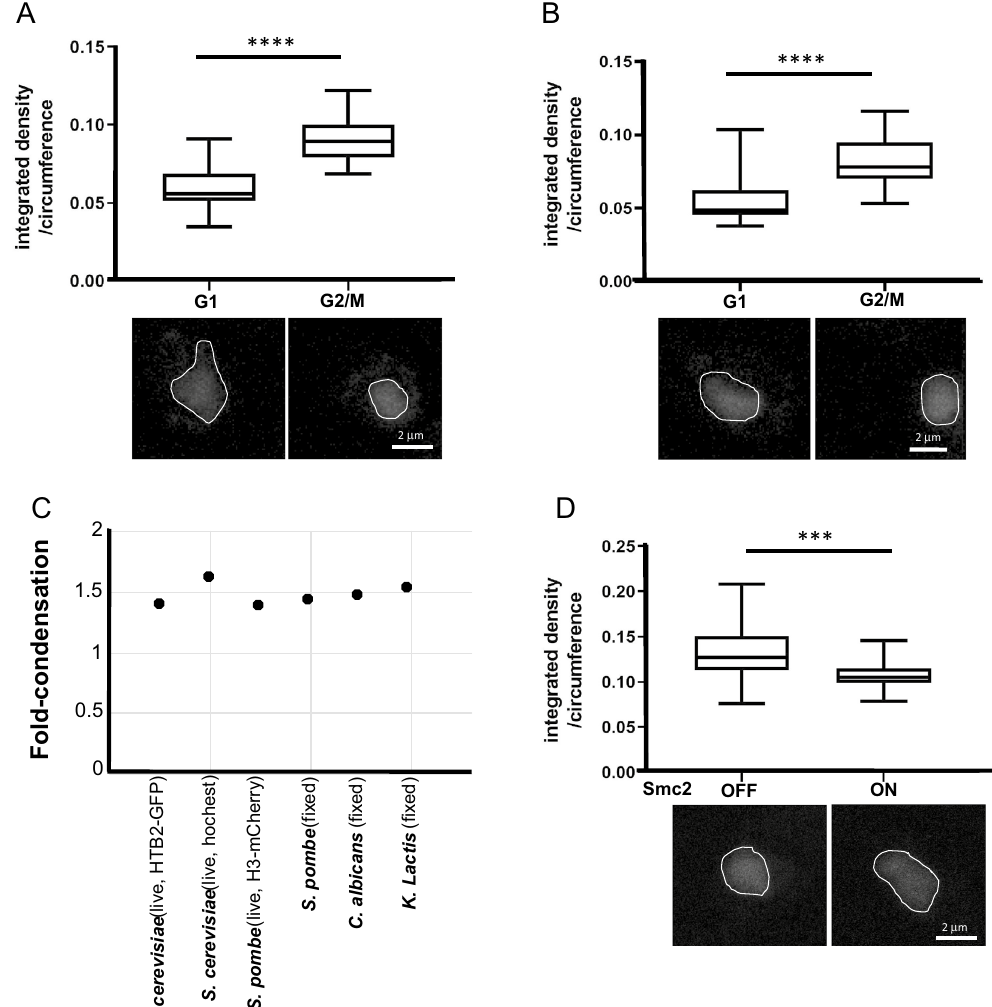
Figure 2. Analysis of chromosome compaction in different yeast cells. ( A ) K. lactis cells were grown, fixed, and stained with DAPI. 25 nuclei were analyzed from each cell cycle phase. **** p < 0.0001. ( B ) C. albicans cells were fixed and stained with DAPI. 30 nuclei were analyzed from each cell cycle phase. **** p < 0.0001. ( C ) Fold-compaction of chromatin in G2/M phase relative to G1 phase for yeast species is indicated. 25 nuclei were analyzed from each cell cycle phase. ( D ) C. albicans cells of strain Y30 ( Ptet- SMC2) were grown to mid- log phase without and with doxycycline, fixed, and stained with DAPI. G2/M phase cells were selected based on morphology and analyzed via two-photon microscopy. 30 nuclei were analyzed from each condition. **** p <